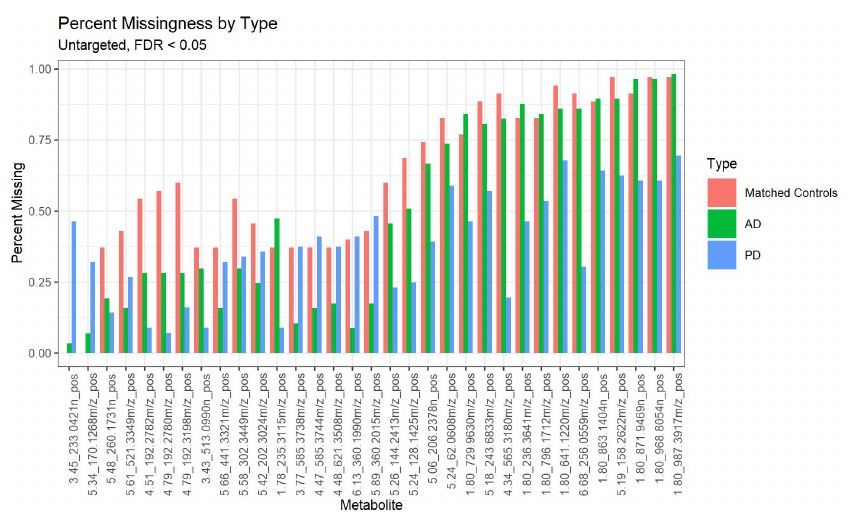
Figure A4. For metabolites with widely varying amounts of abundance missingness by phenotype (AD, PD, age-matched controls), PD tend to have the least missing data. Plotted is the percent missingness of untargeted metabolites for which univariate logistic regressions classifying its missingness across subjects using phenotype contained a FDR < 0.05. The controls used for this analysis were found by matching each member of the AD/PD cohort to the control of closest age, removing duplicates. Metabolites are listed by their retention time, neutral mass (DA), and mode, with each value separated by an